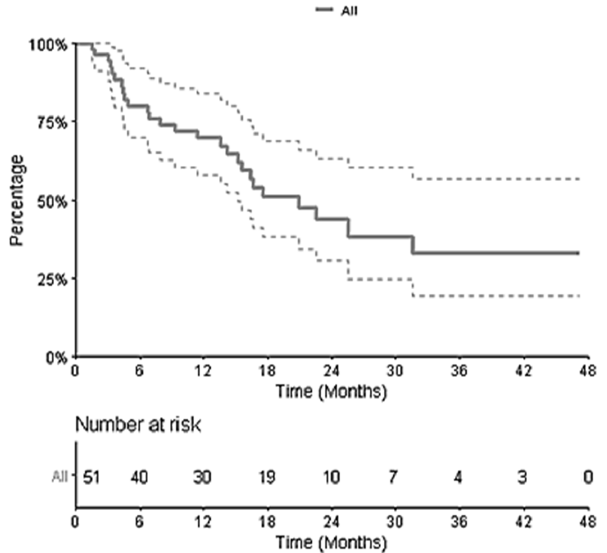
Figure 2. Kaplan–Meier Curve of Overall Survival for the 51 patients. Concerning distant intracranial control, for the 84 metastases, the 1-year and 2-year R- PFI were 40.1% (95% CI [30.1–53.3]) and 35.2% (95% CI [25.1–49.4]), respectively (Figure 3A). The median time to local relapse was 4.14 months. The 1-year and 2-year L-PFI were both 76.4% (95% CI [67.0–87.0]) (Figure 3B). R-PFI tended to be longer in patients treated with ‘concurrent SRT and IT’ than in those treated with SRT before or after IT (Table S2). Indeed, the 1-year R-PFI in ‘concurrent SRT and IT,’ ‘SRT before IT,’ and ‘SRT after IT’ was 49.6% (95% CI [36.1–68.3]), 24.1% (95% CI [10.3–56.3]), and 34.2% (95% CI [17.6–66.3]), respectively ( p = 0.094) (Figure 4A). The L-PFI was similar in the three groups. One-year L-PFI was 78.9% (95% CI [66.8–93.3]) in the ‘concurrent SRT and IT’ group vs. 70.1% (95% CI [51.2–96.0]) in the ‘SRT before IT’ group vs. 77.8% (95% CI [60.6–99.8]) in the ‘SRT after IT’ group ( p = 0.79) (Figure